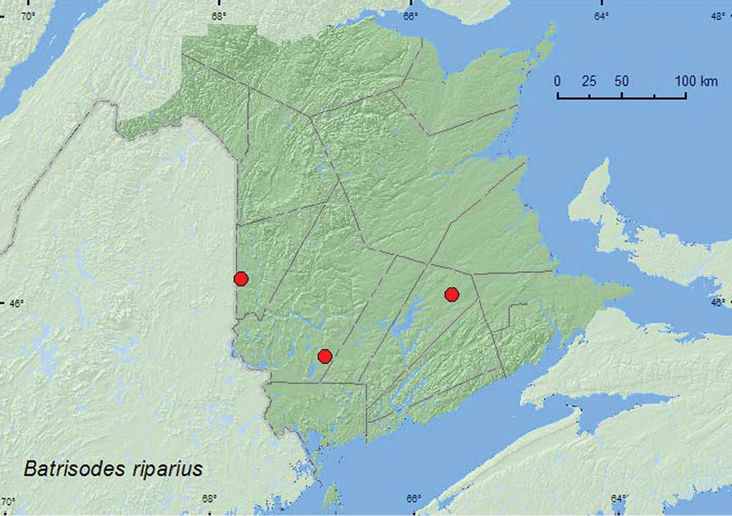
Collection localities in New Brunswick, Canada of Batrisodes riparius.